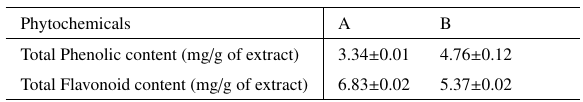
Table 3. Quantitative analysis of phytochemicals in in fresh (A) and decaying (B) macrophytes. Phytochemicals A B